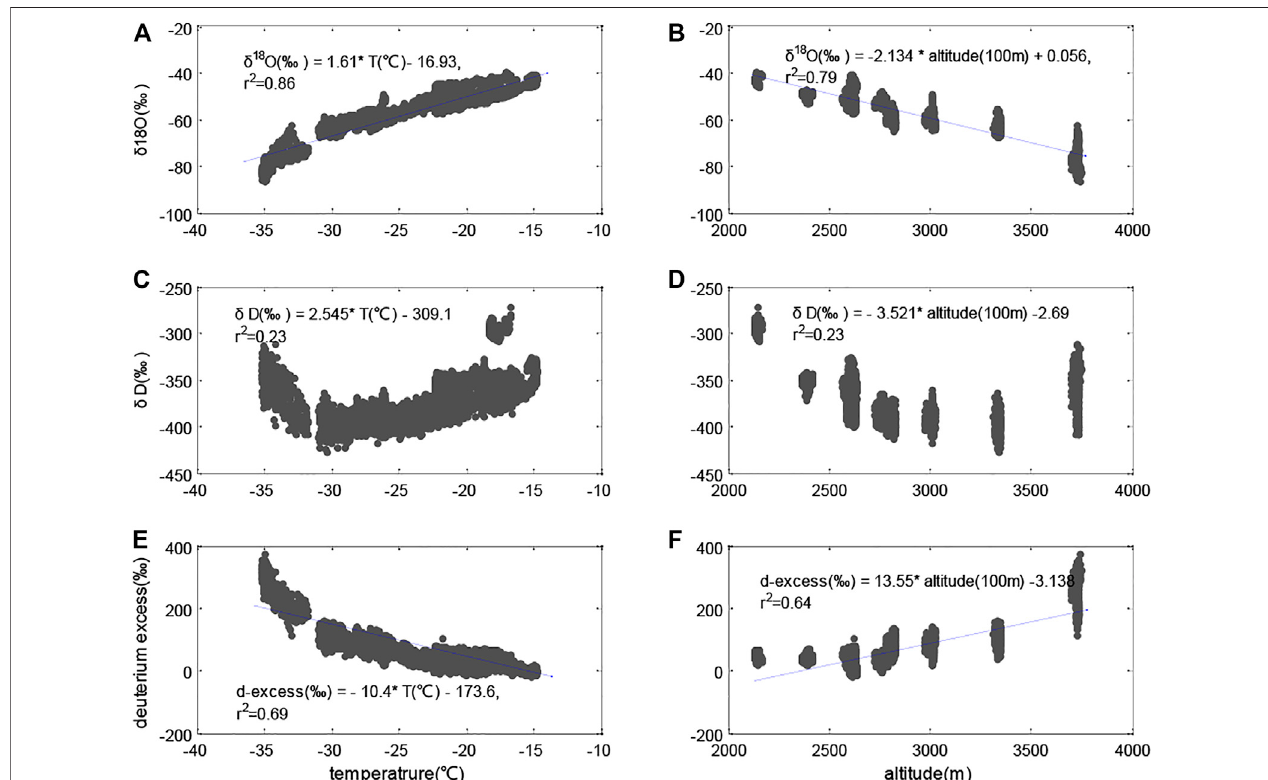
FIGURE 4 | Atmospheric water vapor isotopic composition measured along the transect from Zhongshan Station to Dome A and the relationships between δ 18 O (A,B) , δ D (C,D) , and d-excess (E,F) with temperature and altitude, respectively.